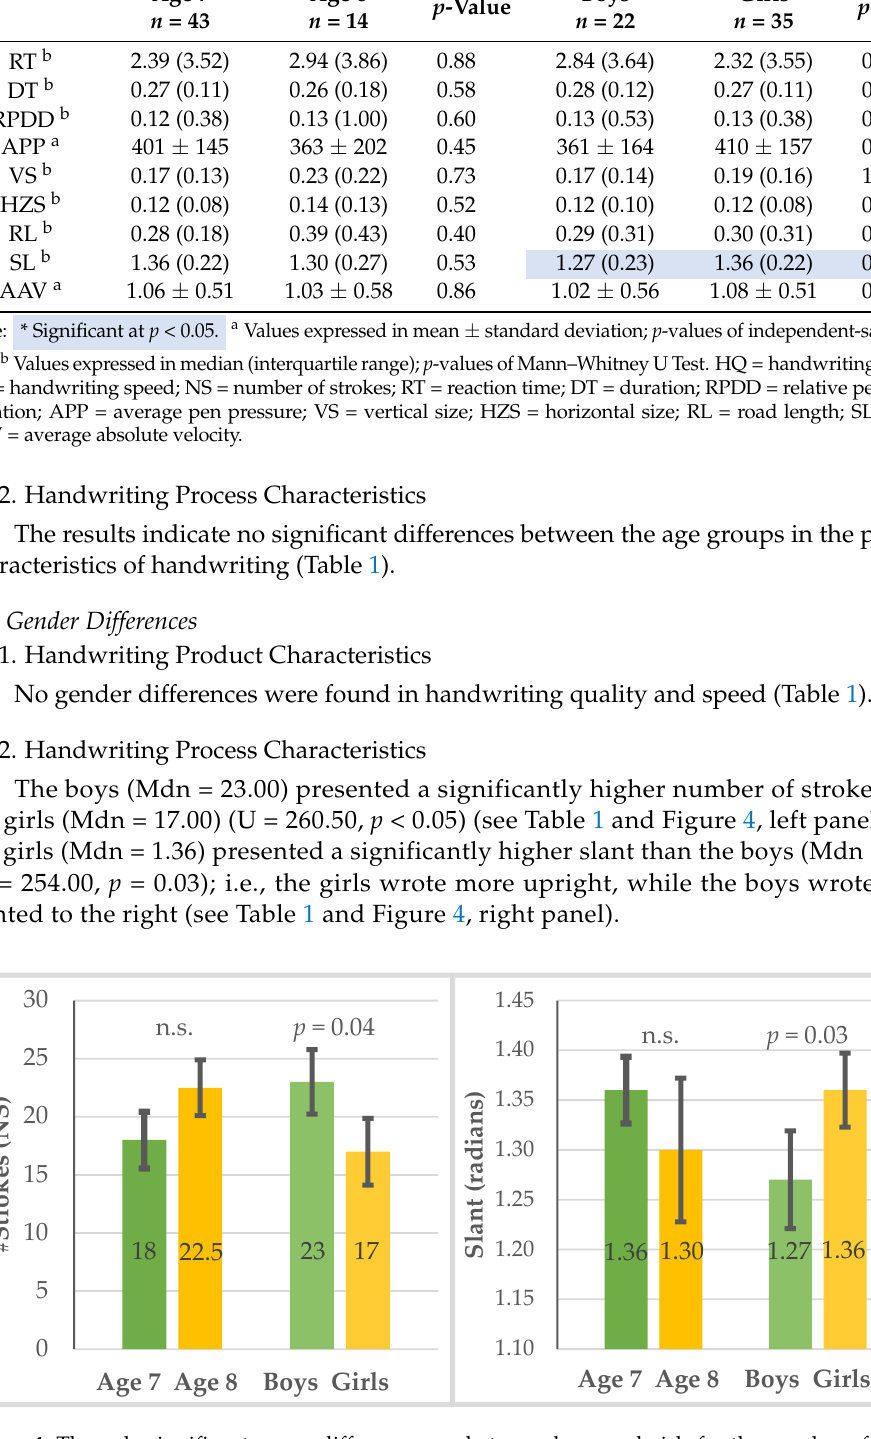
Figure 4. The only significant group differences are between boys and girls for the number of strokes (left panel) and the slant in radians (right panel) (1.27 rad = 73 deg, 1.36 rad = 78 deg). Finally, no gender differences were found for the other features (i.e., reaction time, duration, relative pen-down duration, average pen pressure, vertical size, horizontal size, road length, and average absolute